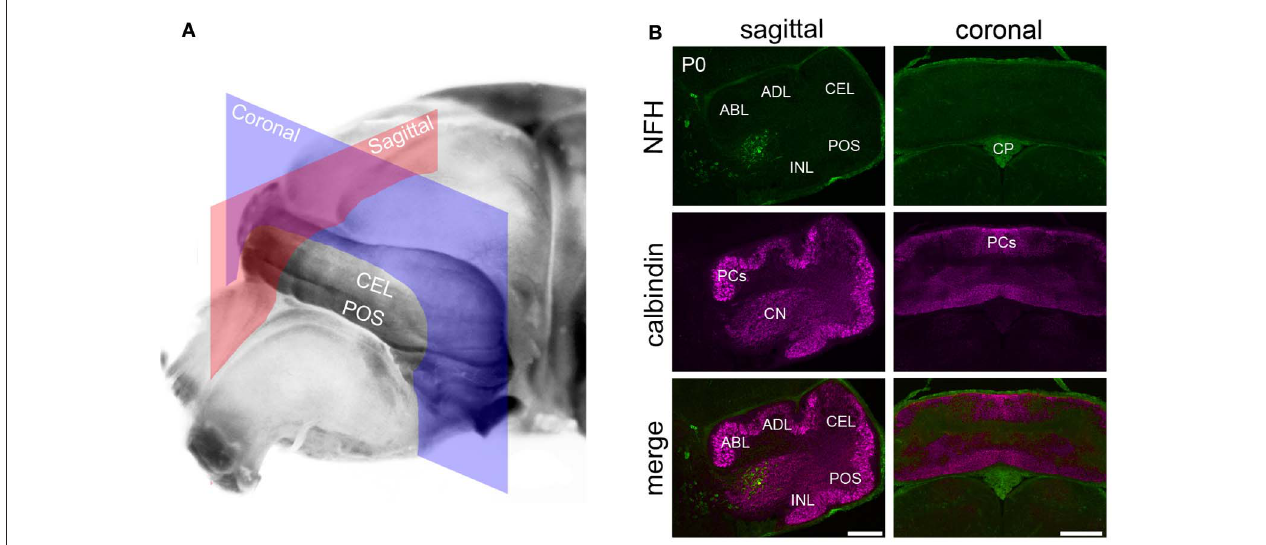
FIGURE 1 | NFH is expressed in the cerebellar nuclei of newborn mice. (A) An unstained brain at P0 illustrating the cutting planes used to acquire the tissue sections shown in panel (B) . The sagittal plane is shown in red and the coronal plane in blue. (B) NFH labels the CN and not Purkinje cells. Purkinje cells were identified with Calbindin, a specific marker for Purkinje cells. Background staining was detected in the choroid plexus. Abbreviations: